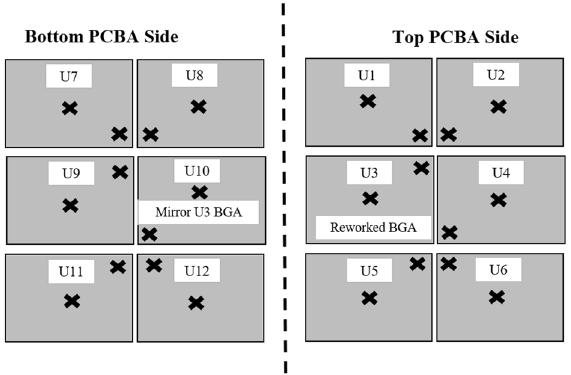
Figure 10. Schematic of TC wires placement locations on reworked and adjacent BGA components of the rework location.